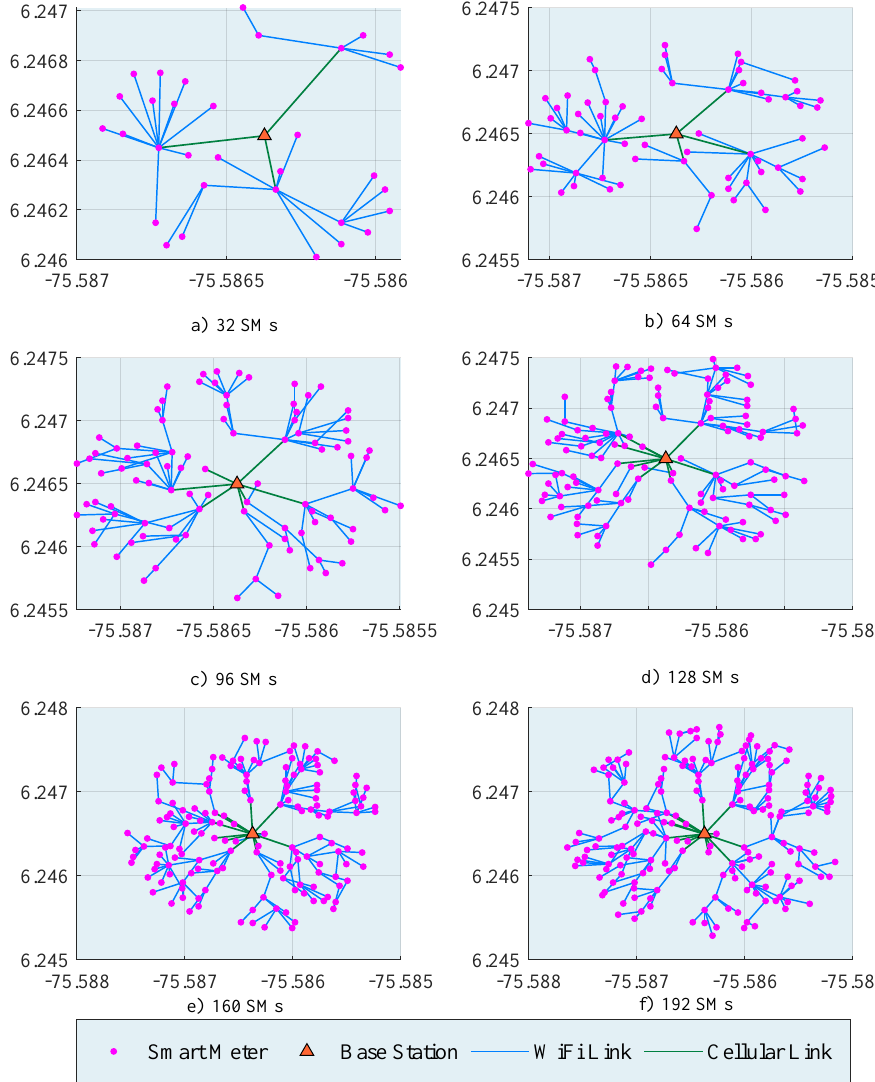
Figure 10. Wireless heterogeneous network (WHN) deployments for different SM population sizes: longitude (x axis) and latitude (y axis)